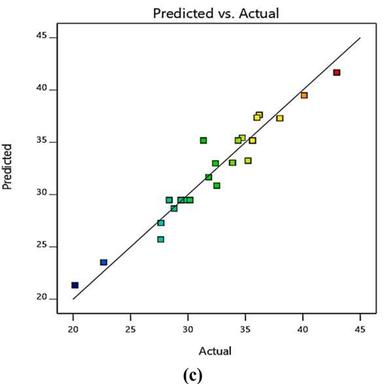
Plots of (a) 3D surface in dark condition; (b) 3D surface in light irradiation; (c) predicted vs. actual values for flux response.